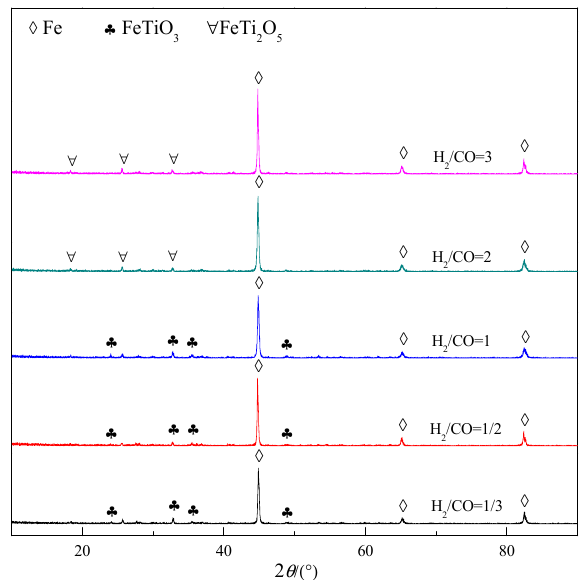
Figure 8. XRD patterns of reduction products at 1273 K with H 2 /(H 2 + CO) ratios. Figure 9a,b show the plot of 1 − (1 − (cid:1844))